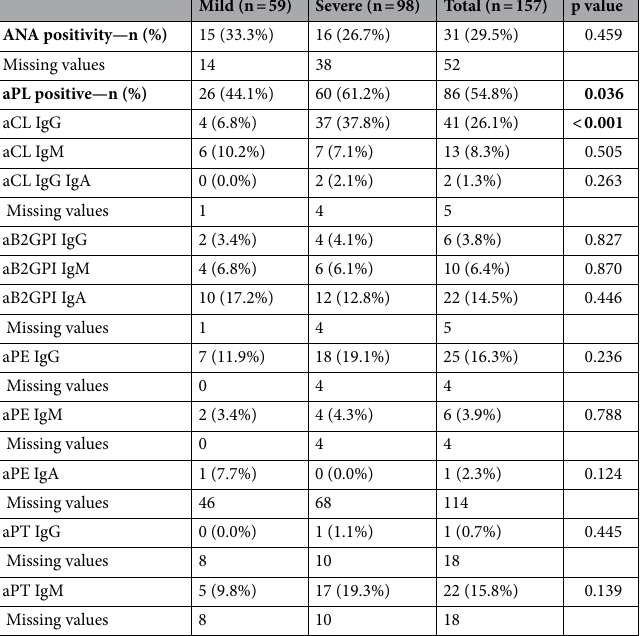
Table 2. Antinuclear and antiphospholipid autoantibodies in patients with COVID-19. aPL antiphospholipid, aCL anti-cardiolipin, aB2GPI anti-beta-2 glycoprotein I, aPE anti-phosphatidylethanolamine, aPT anti- prothombin autoantibodies, ANA antinuclear autoantibodies.